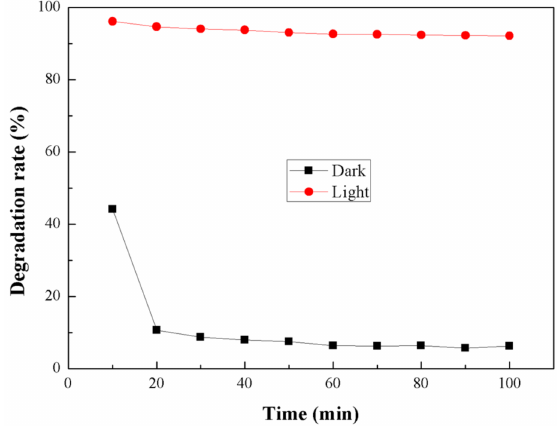
Figure 11. Degradation of ammonia under dark and